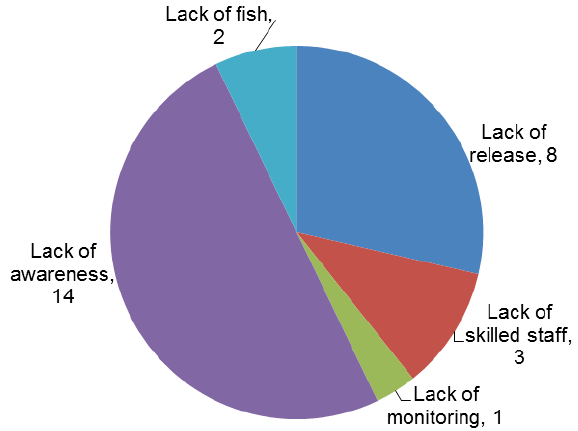
Figure 1. Responses about constrains for crocodile conservation